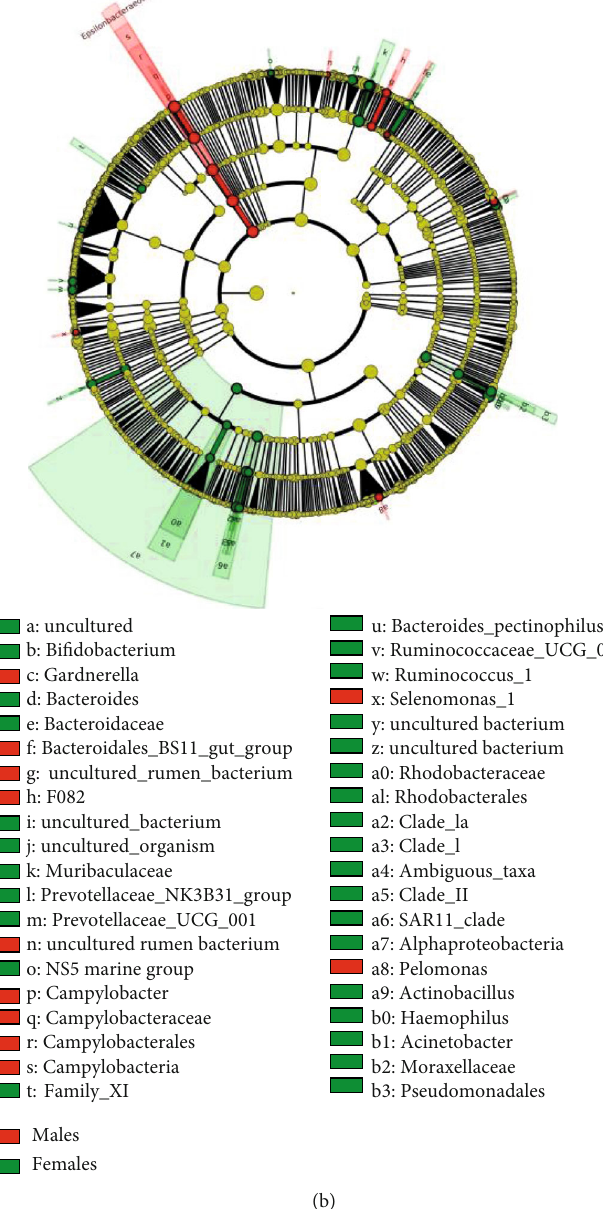
Figure 5: Di ff erent rich taxa between elderly males and females with stage 1 periodontitis analyzed by the linear discriminant analysis e ff ect size. (a) Histogram of the LDA scores. (b) The phylogenetic tree in the form of a